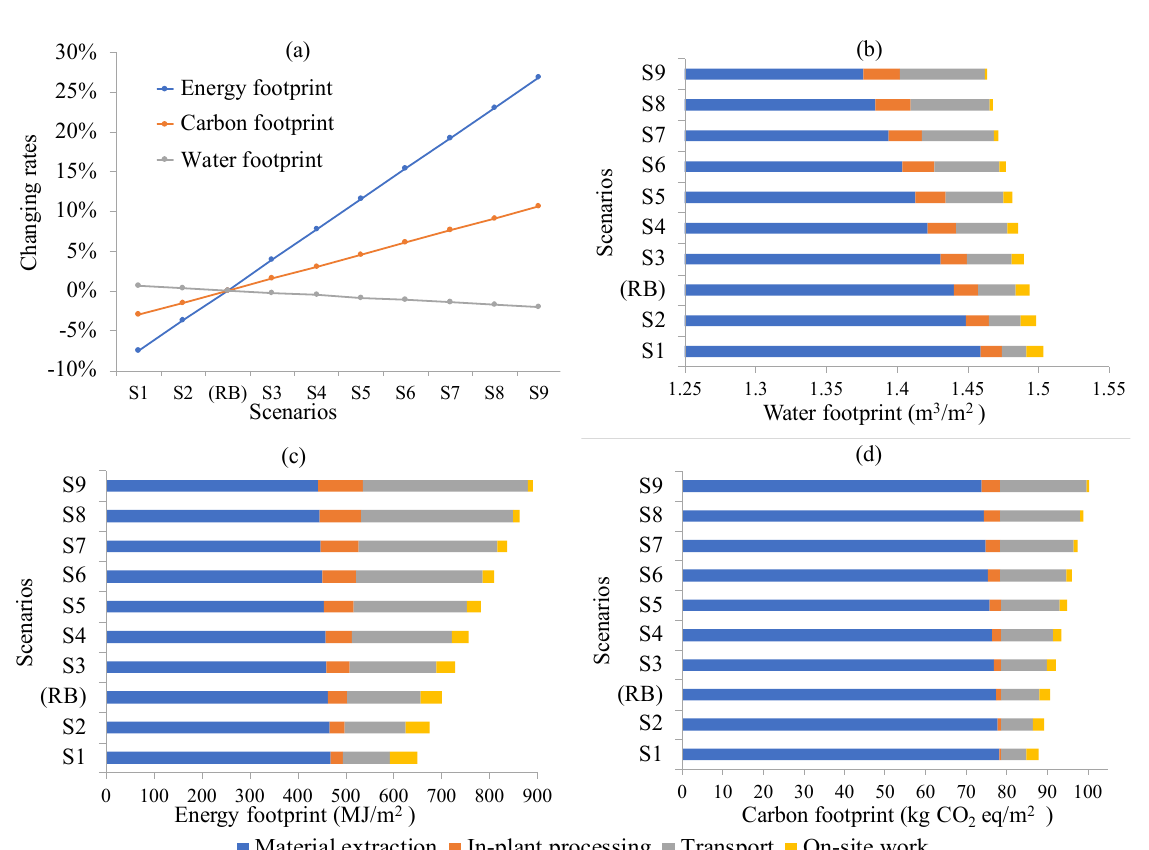
Figure 3. ( a ) The changing rates of environmental impacts and the changes in ( b ) water footprint, ( c ) energy footprint, and ( d ) carbon footprint during each lifecycle stage in the scenarios.